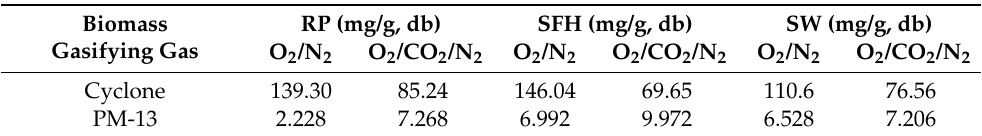
Table 2. Effect of the gasifying atmosphere on the mass of particles, sampled with both cyclones and with the 13-stage impactor (PM-13).